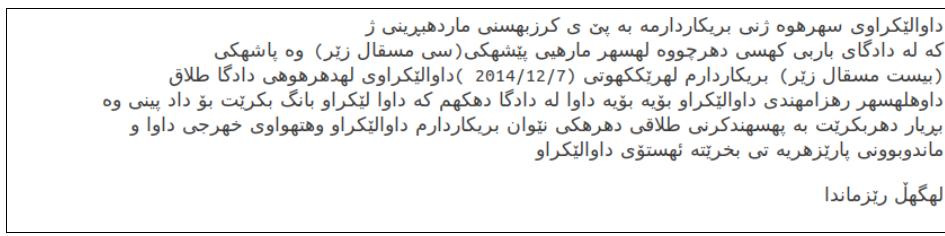
Figure 6. OCRed text of actual Court’s document image.